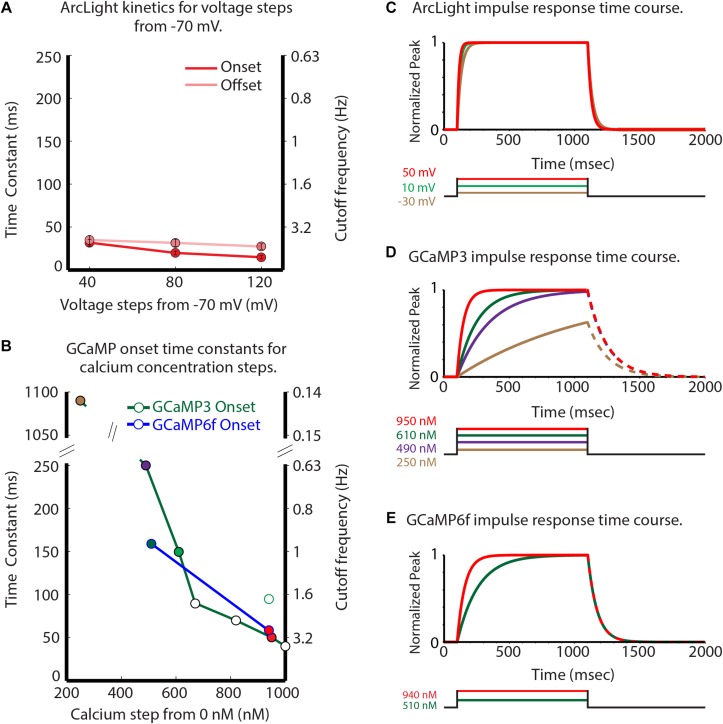
Comparison of the GEVI and GECI sensor kinetic properties. Experimentally measured ArcLight values for different depolarizing steps are compared with published and personally communicated values for the GECIs GCaMP3 and GCaMP6f. GCaMP3 and GCaMP6f are considerably slower in their onset response to calcium changes (B) than ArcLight is to membrane potential changes. (A) ArcLight onset (red) and offset (pink) time constants in response to different depolarizing steps from –70 mV in HEK293 cells. (B) The GCaMP3 (green line), and GCaMP6f (blue line) onset time constants in response to different calcium steps (Kim et al., personal communication). (C–E) Normalized impulse responses for ArcLight (C), GCaMP3 (D), and GCaMP6f (E) to physiologically relevant steps of voltage and calcium. The GCaMP offset rates in panels (D,E) are shown as dashed lines to indicate the possibility that they could be sensitive to the magnitude of the calcium change. Modified from Storace et al. (2015).